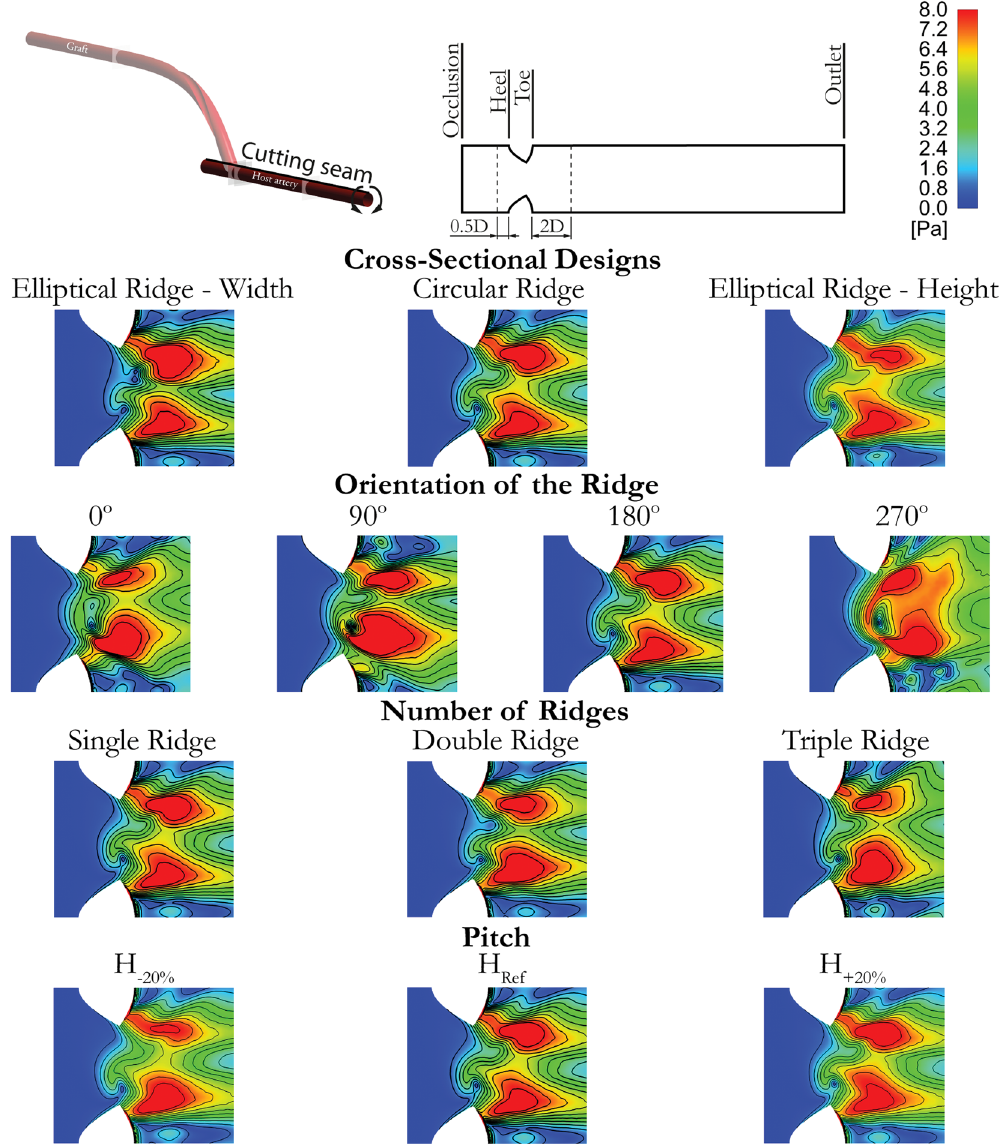
Figure 3. Distributions of WSS onto the developed surface of the host artery for different ridge